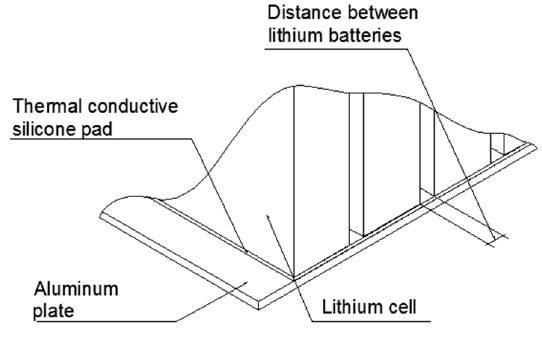
Figure 8. Detailed module structure. Table 3. Thermal properties of the Silica gel pad and mixed solution.